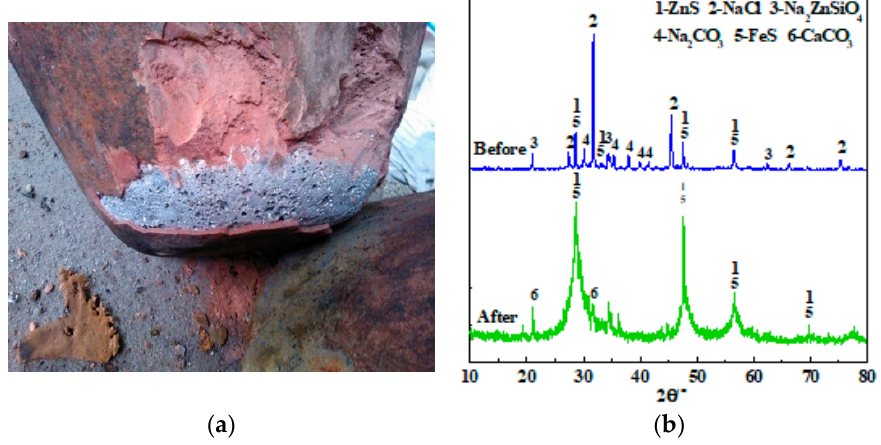
Figure 6. ( a ) Stratification of smelting products, and ( b ) XRD patterns of molten salt residue before and after water dissolution.